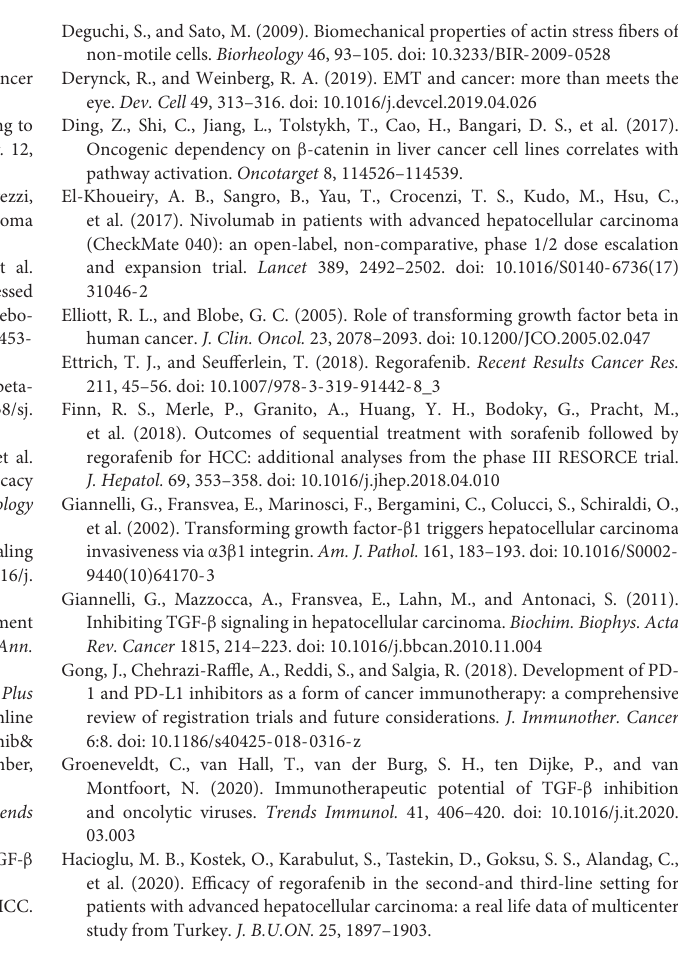
Supplementary Figure 1 | Regorefenib treatment significantly inhibits (A) in vitro migration, (B) spheroid growth and (C) colony formation of hepatoblast-like cell lines. Supplementary Figure 2 | (A) Sub-G1 analysis of Wnt3/RSpo treated HuH7 cells (B) cleaved PARP analysis of Wnt3/RSpo treated HepG2 cells. (C) cleaved PARP analysis of IWR-1 treated cells Hep3B and HepG2 cells. Supplementary Figure 3 | (A) Phase-contrast image, (B) phalloidin staining and (C) EpCAM staining of acute regorafenib treated cells. (D) Phase contrast images and (E) TCF/LEF activity of resistant cell lines. Supplementary Figure 4 | (A) In vitro migration, (B) spheroid formation and (C) colony formation of TGF β -R1 treated SRC cells. Supplementary Figure 5 | (A) SA- β -gal staining of TGF- β 1 treated, TGF β -R1 treated and DOX treated cells. (B) Spheroid formation of sh-TGF β -R1 cells. Supplementary Table 1 | qPCR Taqman specific